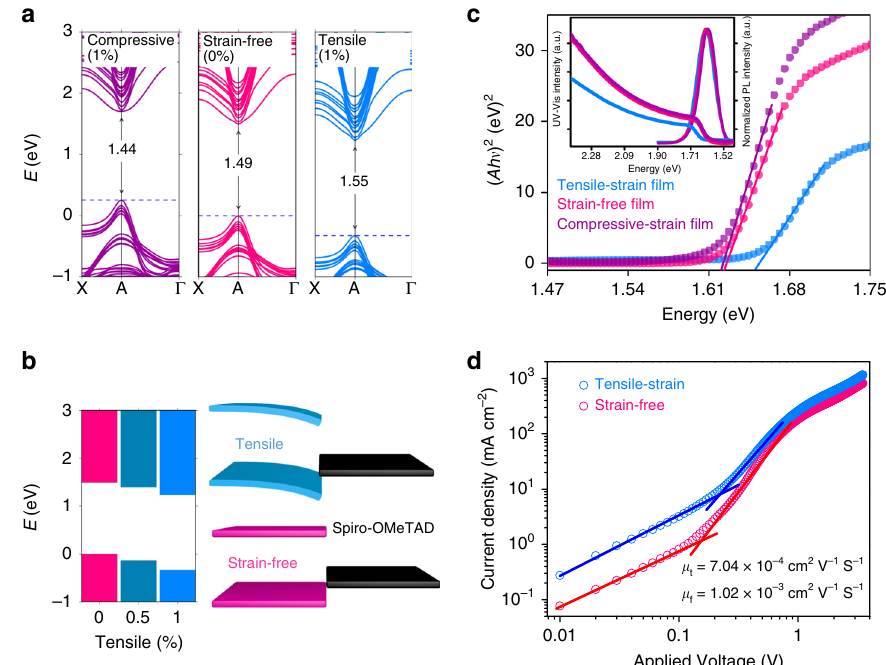
Fig. 4 Strain-induced electronic structure analysis. a Calculated band structures under biaxial tensile, zero, and compressive strains from fi rst-principle density functional theory (DFT)-based approaches. The band structure alignment is made by using the vacuum energy level as reference. b The evolution of band-edge energies under gradually increasing tensile strains in perovskite fi lms (left panel), and the schematic of the band alignment between tensile strain/strain-free fi lm and hole transport layer in solar cell. c Ultraviolet (UV) – visible (Vis) absorption spectra and PL spectra under tensile strain, strain- free, and compressive strain conditions. d The J – V characteristics of the hole-only space-charge-limited current (SCLC) device with/without residual tensile